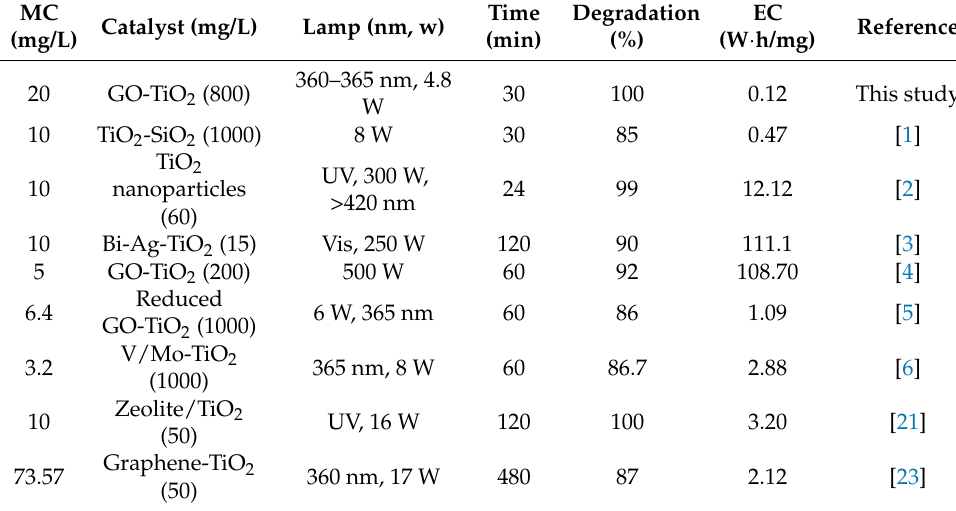
Table 1. Recent studies on MC degradation with UVA photocatalysis.